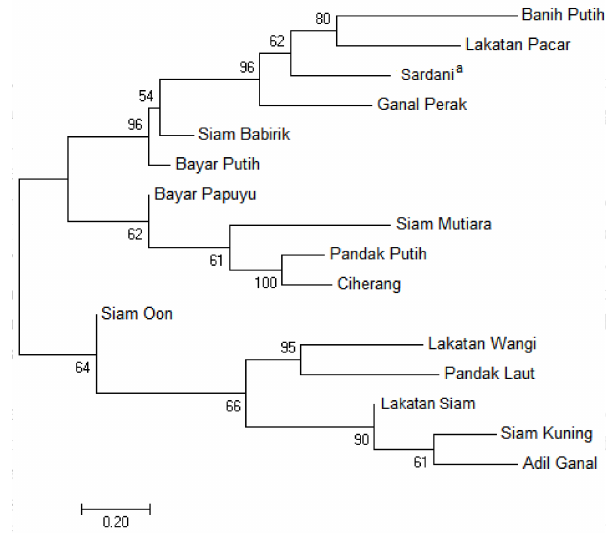
Figure 3. Phylogenetic tree of the tidal swamp rice based on the nuclear IGS sequences. The numbers above branches indicate bootstrap values inferred from 1000 replicates ( a an